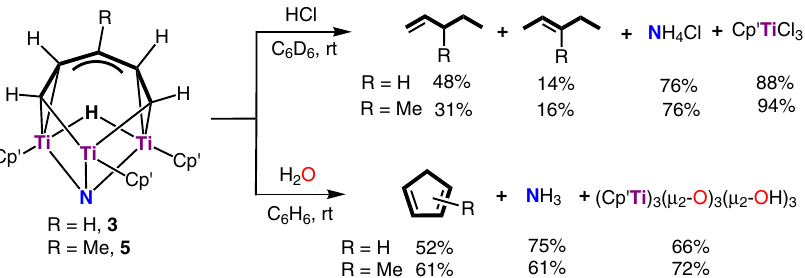
Fig. 5 Hydrolysis reactions of 3 and 5 with HCl and H 2 O. The reaction of 3 and 5 with HCl yielded the linear nitrogen-free hydrocarbons with the release of NH 4 Cl, while the reaction with H 2 O afforded the cyclic hydrocarbon products with the release of NH 3